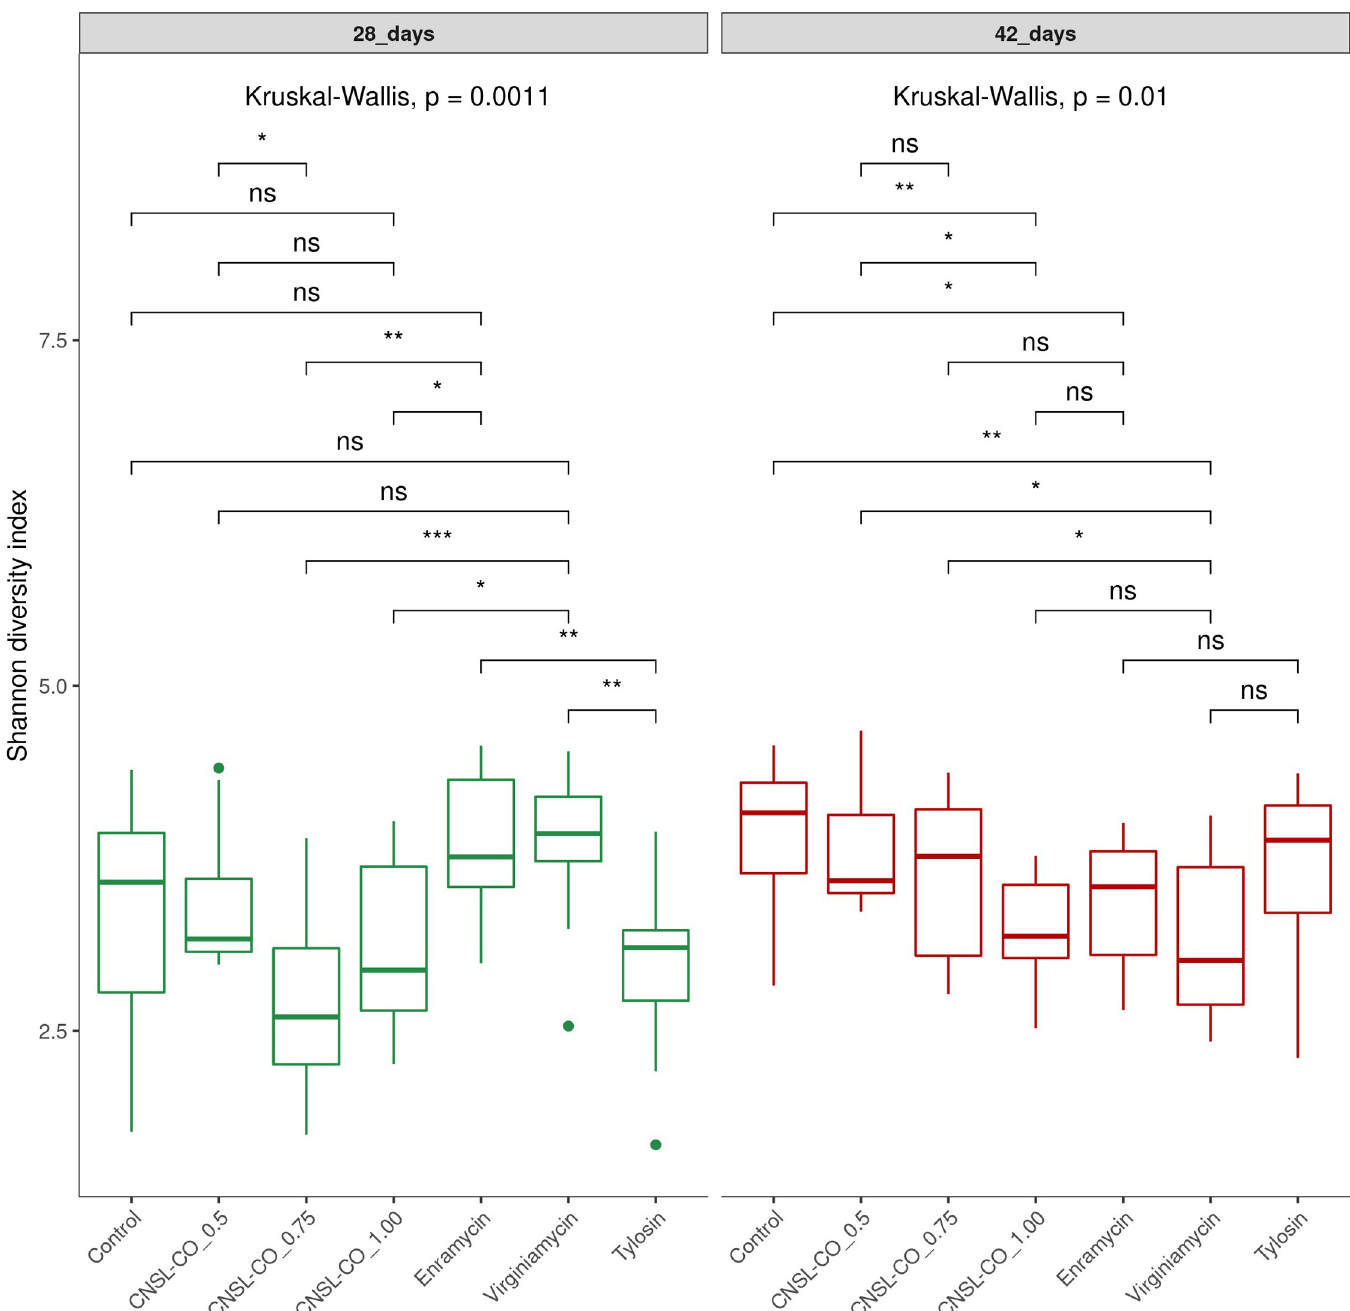
Fig 3. Comparison of alpha diversity at each time point using Shannon index of broilers cecum samples at 28 and 42 d of trial. The study tested seven feed additives: enramycin (8 ppm), virginiamycin (16.5 ppm), tylosin (55 ppm), CNSL-castor oil (CNSL-CO) at different doses (0.5, 0.75, and 1.00 kg/t), and the control diet (without additives). Probabilities and means with different letters differ statistically by Tukey: 0 ‘ ��� ’ 0.001 ‘ �� ’ 0.01 ‘ � ’